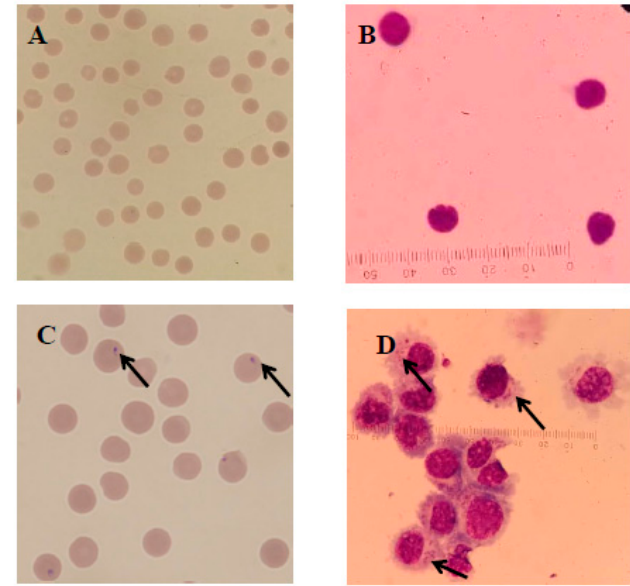
Figure 2. Microscopic examination of T. annulata merozoites in red blood cells (RBCs) and macroschizonts in transformed B cells as well as normal cells stained with Giemsa observed under a compound microscope at 1000×. Here, ( A , B ) represent the normal RBCs and lymphocytes, respectively, while the arrows in ( C , D ) show the presence of merozoites in the RBCs of infected cattle and macroschizonts in the established cell line, respectively.